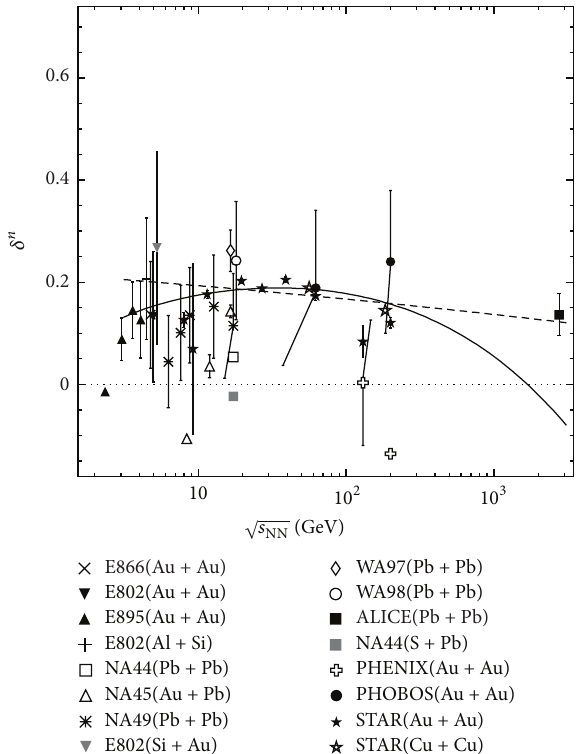
Figure 5: Dependence of scaled difference of squares of transverse radii on collision energy for emission region of secondary charged pion in various nucleus-nucleus collisions at ⟨𝑘 ⊥ ⟩ ≃ 0.2 GeV/ 𝑐 . Experimental results are shown for the same particle types and Coulomb corrections as well as in Figure 4. Error bars are only statistical (for NA44, total uncertainties). Dotted line is the level 𝛿 𝑛 = 0 . Smooth curves are derived from (6) and the fit results for 𝑅 𝑛 𝑅 𝑛 𝑠 , 𝑜 . The solid line corresponds to the fits of scaled HBT radii by function (7) and dashed line to the fits by specific case 𝑅 𝑛 𝑖 ∝ ln 𝜀 , 𝑖 = 𝑠,𝑜